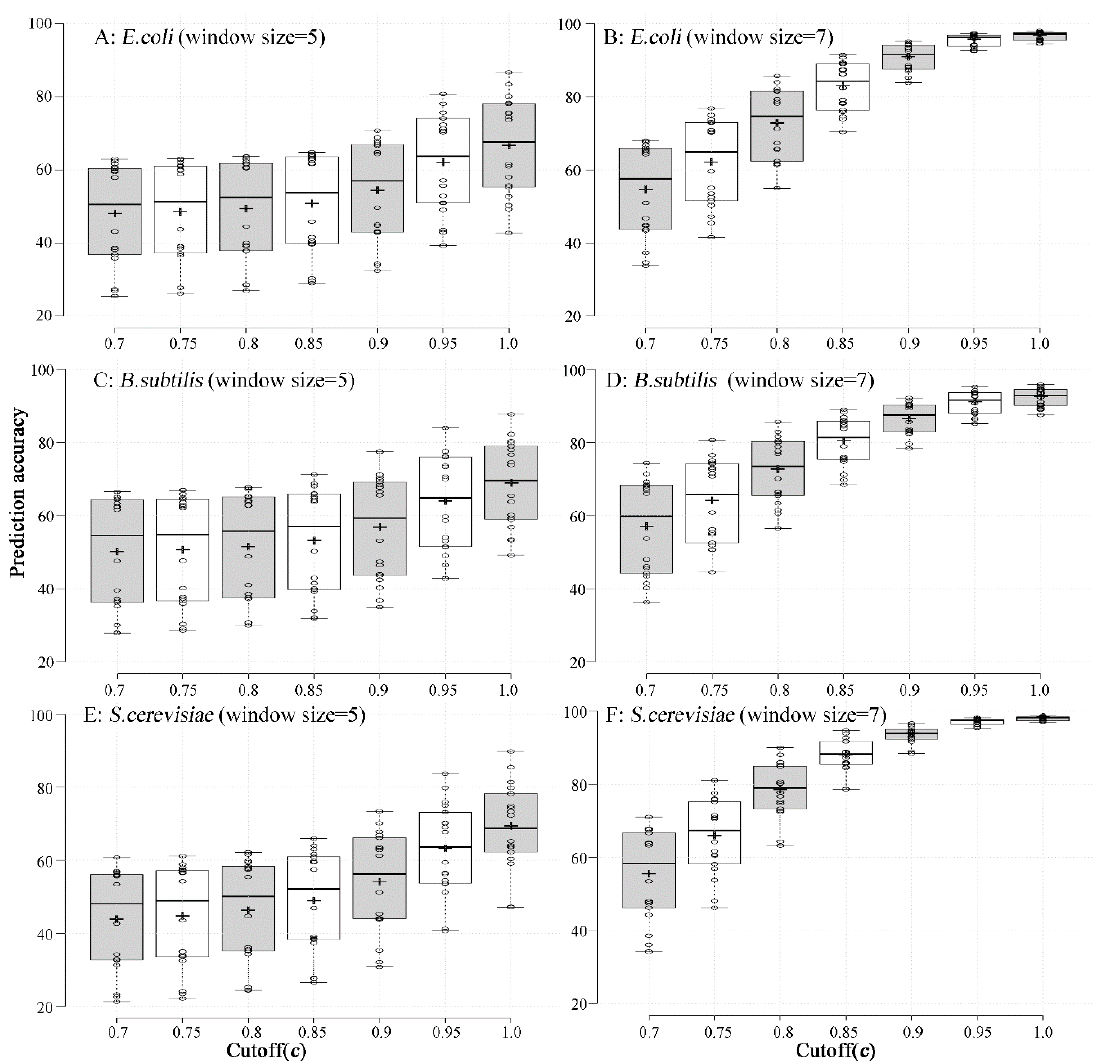
Figure 2. The prediction performance of the 18 classifiers for the 18 amino acids, with different matched cut-offs and window sizes (left: Five amino acids; right: Seven amino acids) in E. coli , B. subtilis , and S. cerevisiae . The x -axis is the matched percent and the y -axis is the prediction accuracy of the 18 classifiers. Each open circle represents the prediction accuracy with one of the 18 classifiers. The horizontal divisions (from top to bottom) in each box are the upper whisker, 3rd quartile, median, 1st quartile, and lower whisker, respectively. The cross line in each box is the mean prediction accuracy of all 18 classifiers. All of the results were calculated based on a ten-fold cross validation.